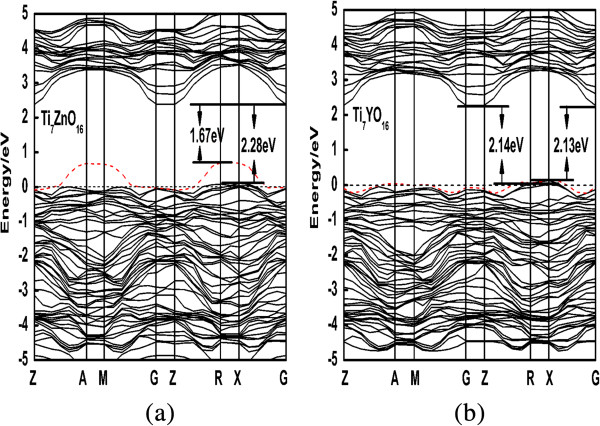
Calculated band structure. (a) Zn-doped anatase TiO2; (b) Y-doped anatase TiO2.